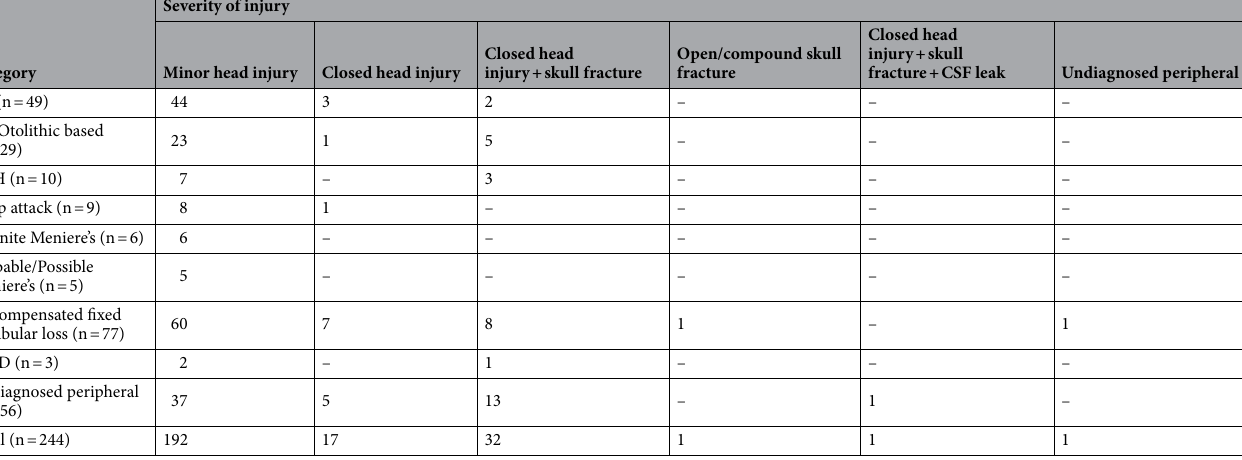
Table 5. Severity of head injury following head trauma in the common types of peripheral vertigo. RV recurrent vestibulopathy, SSCD superior semicircular canal dehiscence, DEH delayed endolymphatic hydrops. Undiagnosed peripheral represented those with a history suggestive for peripheral vestibular dysfunction but defied classification into a recognized subgroup according to symptoms/signs/duration of vertigo